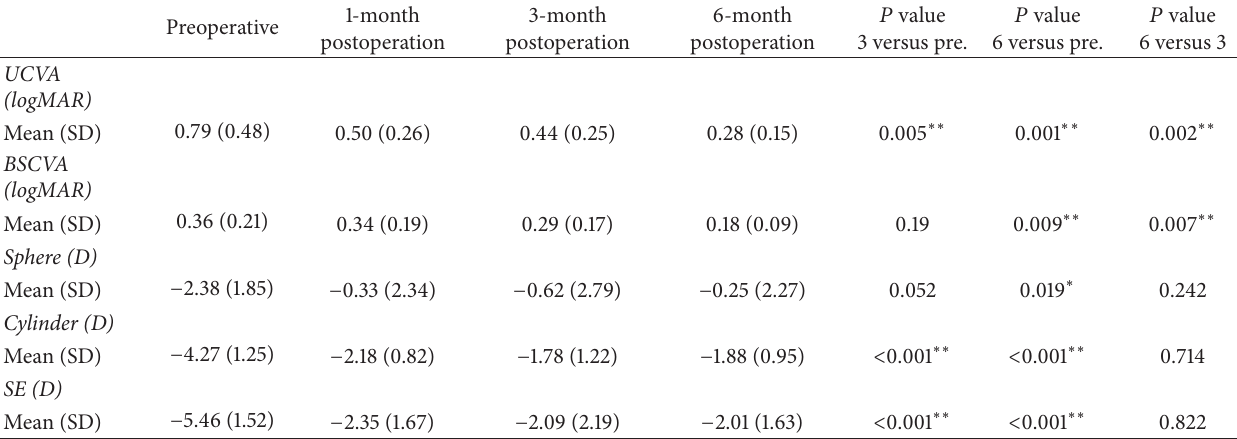
Table 3: Comparison between preoperative and postoperative visual outcomes.